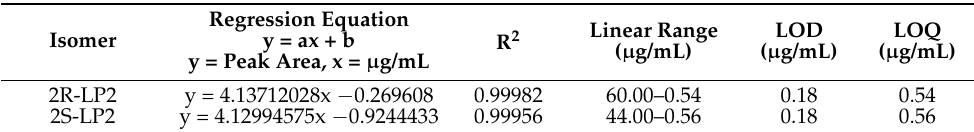
Table 2. Calibration data, limit of detection (LOD), and limit of quantification (LOQ) obtained for HPLC analysis of 2 R / S -LP2.